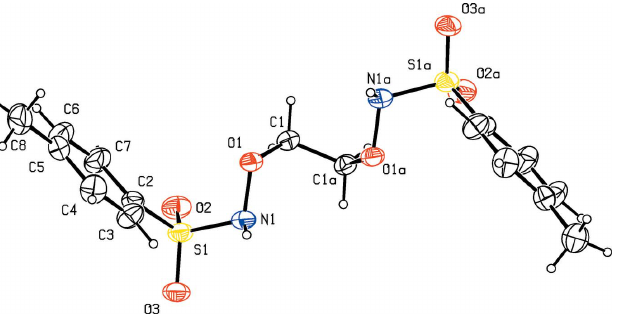
Figure 1 The molecular structure of the title compound, showing the atom labelling. Displacement ellipsoids are drawn at the 20% probability level. Symmetry code: (a) (cid:3) x , y , (cid:3) z (cid:3) 1 . 2